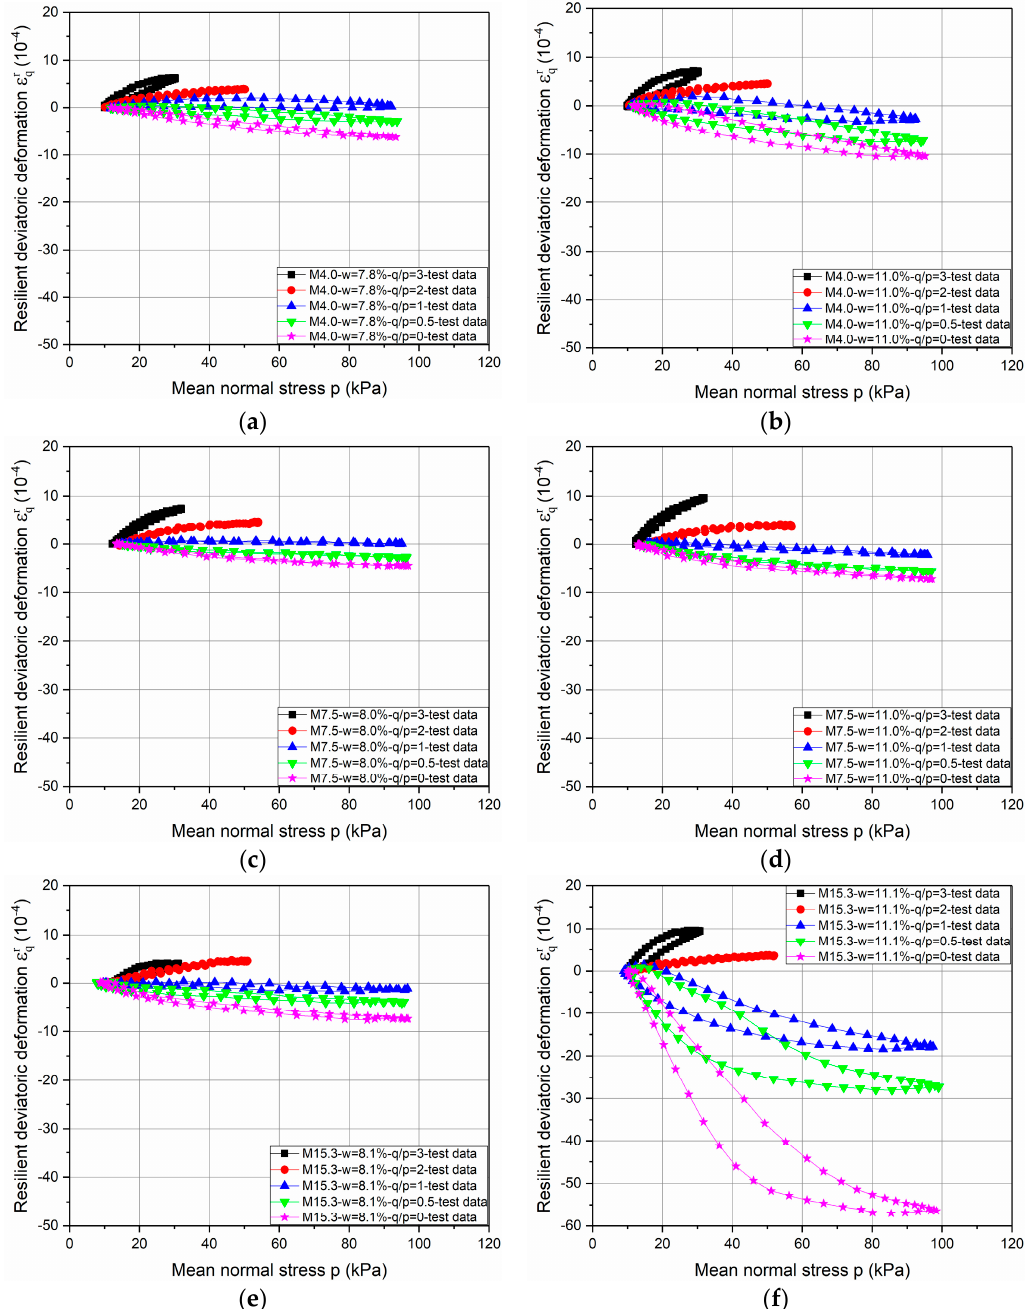
Figure 4. Evolution of resilient deviatoric deformation ε qr for three Missillac sands—M4.0, M7.5, and M15.3—with water contents of w = 8% and w = 11%. ( a ) M4.0- w = 7.8%; ( b ) M4.0- w = 11.0%; ( c ) M7.5- w = 8.0%; ( d ) M7.5- w = 11.0%; ( e ) M15.3- w = 8.1%; ( f ) M15.3- w = 11.1%.